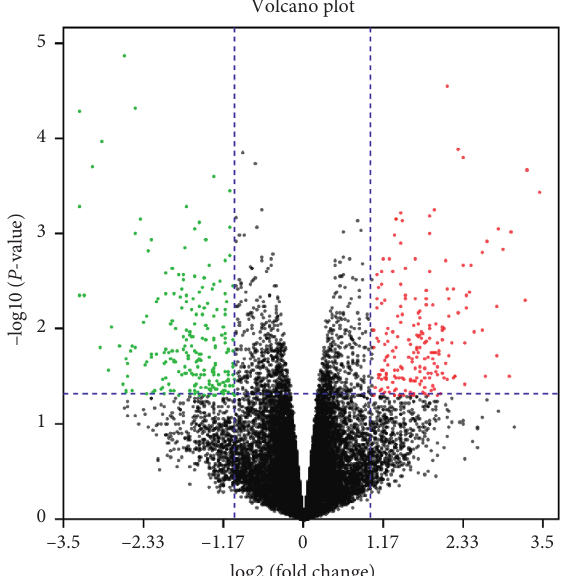
Figure 1: Identification of DEGs between PHN and normal control DRG